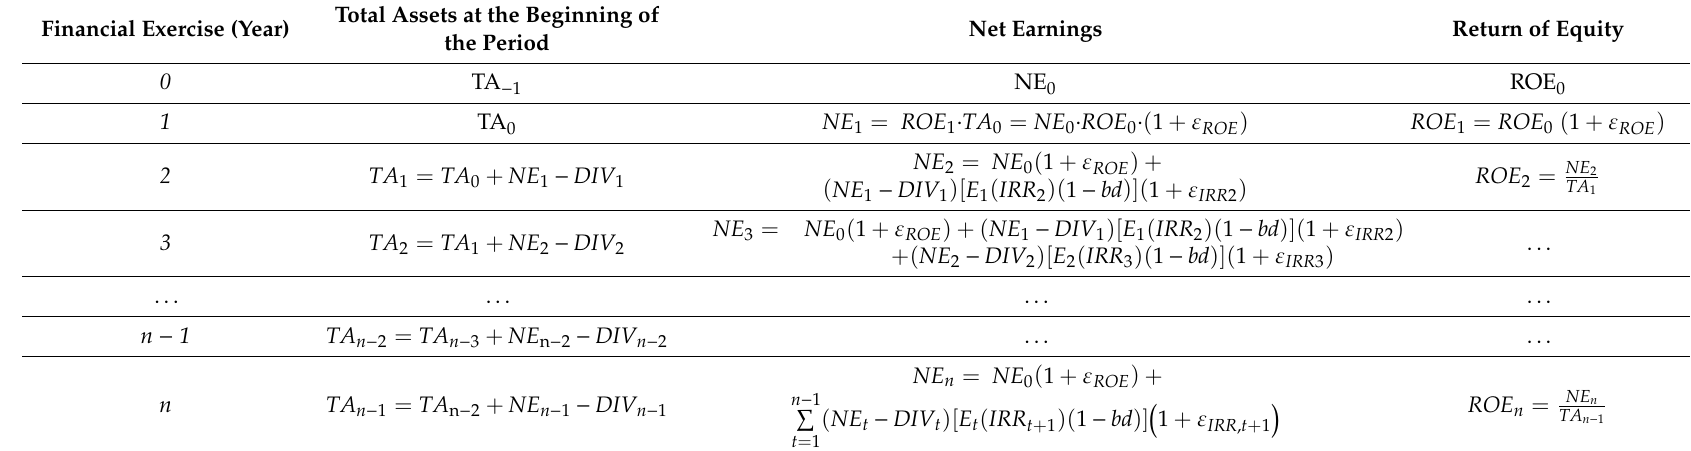
Table 3. Evolution of financial indicators.